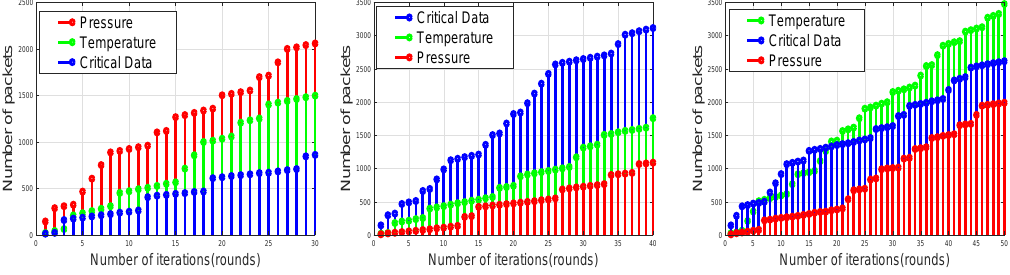
Figure 6. Application-sensitive environmental reporting of the SAMCFIR routing